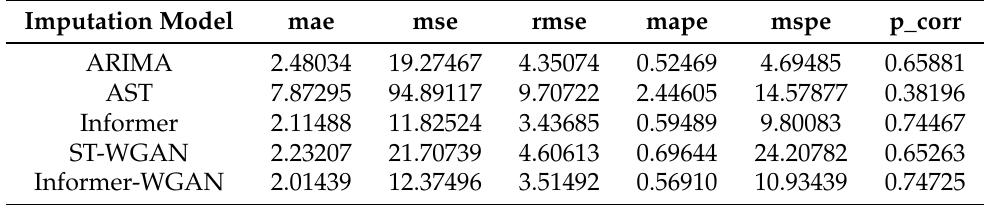
Table 5. The imputation results of different model on electricity dataset at the missing rate of 60%.